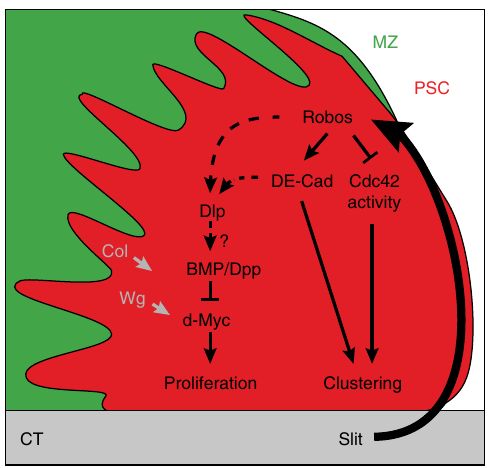
Figure 7 | An integrative model for the role of Robo signalling in the PSC. Our schematic diagram of a WT LG with the PSC in red, the MZ in green and the CT in grey. Slit from the CTactivates the Robo signalling pathway in the PSC. Robo signalling controls PSC cell clustering and proliferation. Proposed interactions between Robos, bone morphogenetic protein/ decapentaplegic (BMP/Dpp) signalling, DE-cadherin and Cdc42 activity for the control of PSC cell proliferation and clustering are indicated. Dlp expression in the PSC is also controlled by Collier/Knot (Col/kn) transcription factor, and Wint/Wingless (Wnt/Wg) signalling activates dmyc expression 20